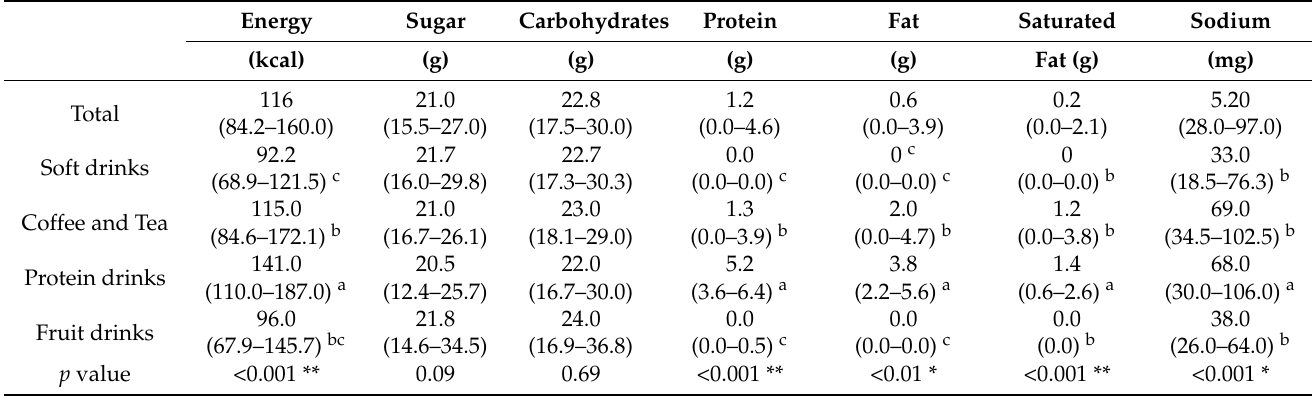
Table 2. Nutritional information for different SSBs 1,2